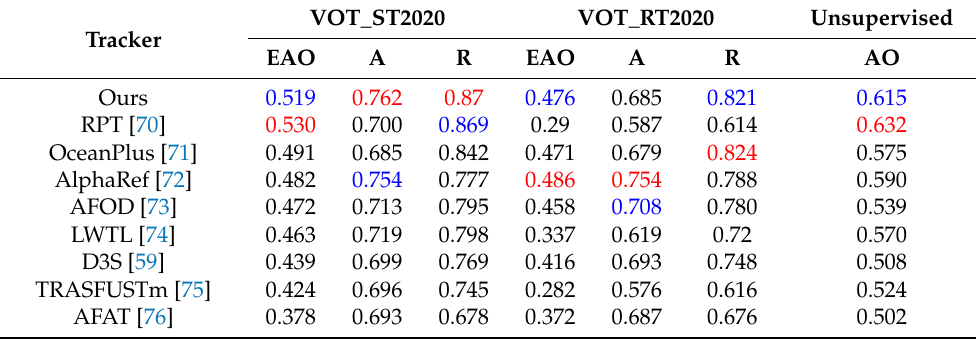
Table 5. Results for VOT-ST2020 and VOT-RT2020 challenges. Expected average overlap (EAO), accuracy and robustness are shown. For reference, a no-reset average overlap AO [38] is shown under Unsupervised . (The value marked in red is the highest, and the blue is the second highest).